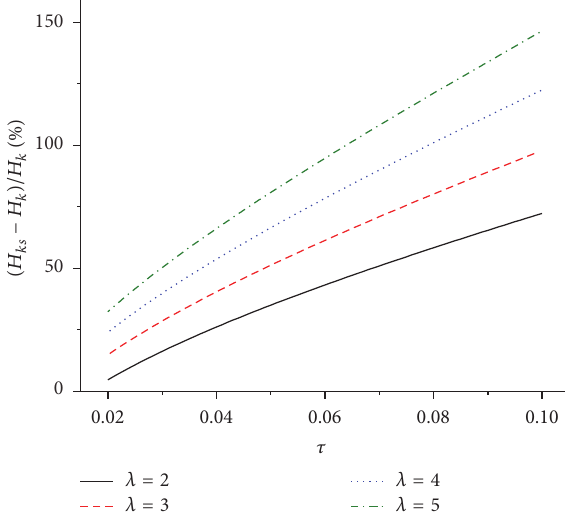
Figure 2: The deviation percentage caused by simplified shape anisotropy with varied 𝜏 and 𝜆